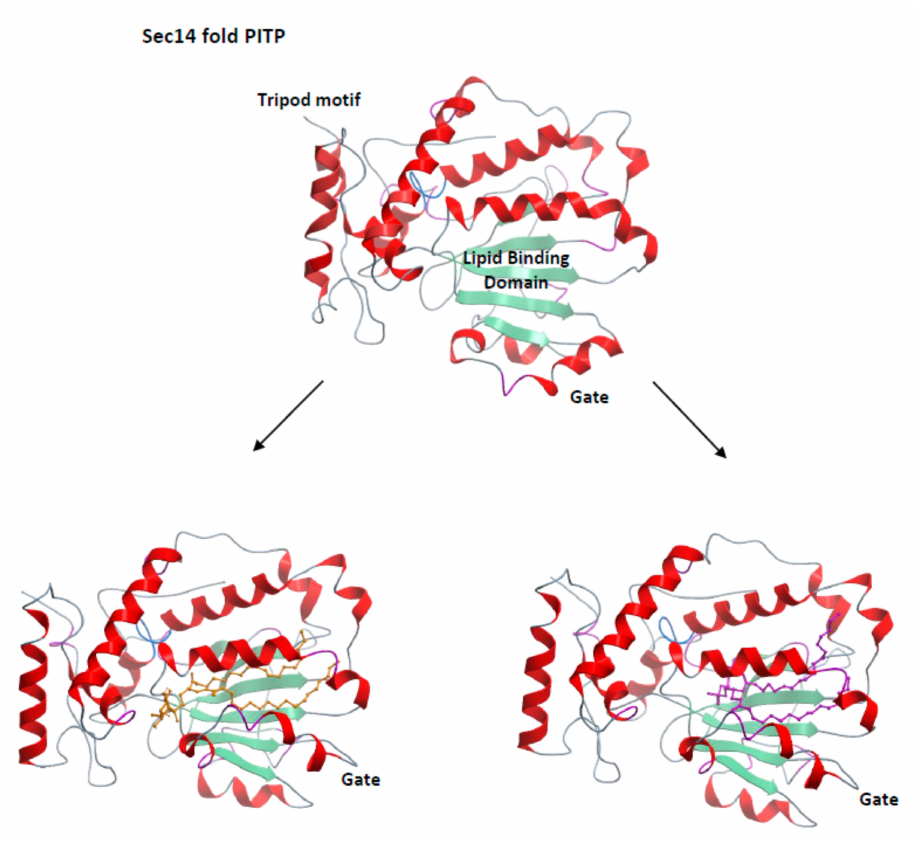
Figure 5. Structural features of Sec14-like PITPs. The Sec14 structural fold is depicted in ribbon diagram. This compact fold consists of two domains, the N-terminal tripod motif and the lipid binding domain whose lipid-binding cavity floor is defined by four parallel β -strands. At top is shown the structure of the lipid-free apo form that describes the open conformer (PDB: 1AUA) where the gate that controls access to the Sec14 lipid binding pocket is swung open. At bottom left and bottom right are depicted PtdIns- (orange ball&stick render) and PtdCho (magenta ball&stick render)-bound holo-forms of the Sec14-fold in the closed conformation, respectively. In both holo forms, the gate has undergone an ~18Å conformational shift to obstruct access to the lipid binding pocket. These holo structures are of a close S. cerevisiae paralog of Sec14 (Sfh1) and the high resolution PtdIns- and PtdCho-bound structures are described in PDB: 3B7N and PDB: 3B7Q,